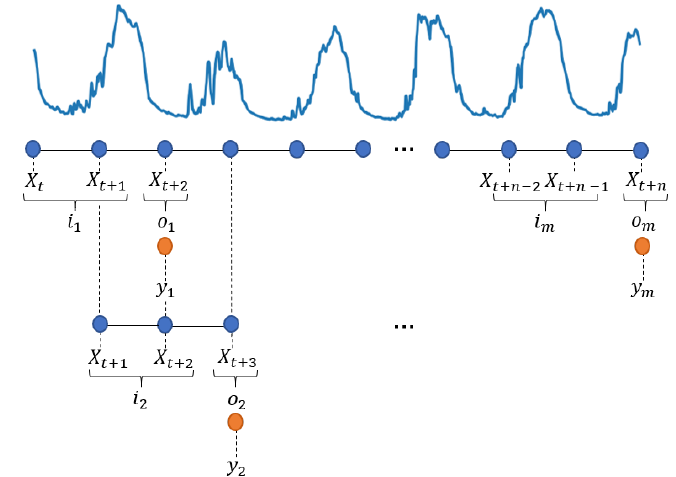
Figure 5. Example of LSTM 2